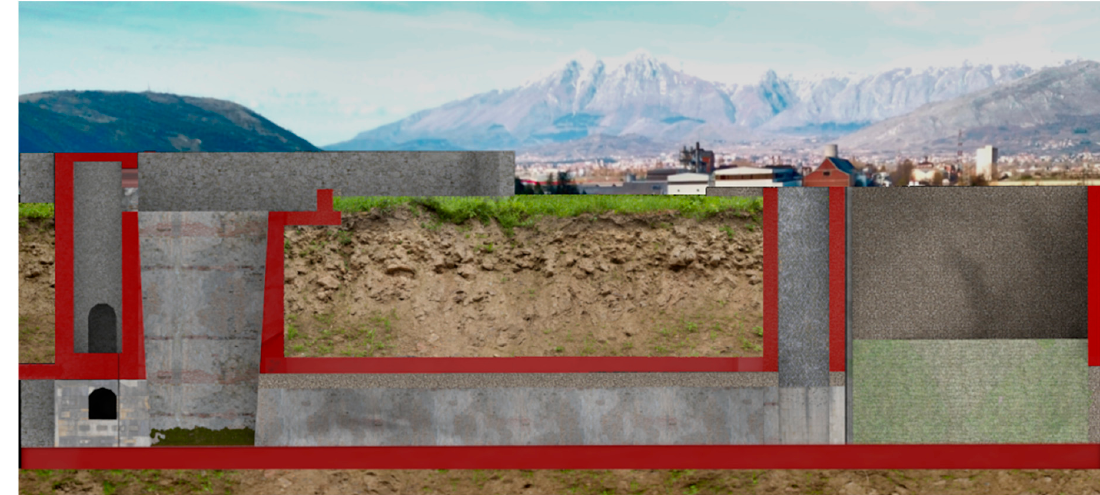
Figure 14. Longitudinal section of the Roman incile in a current setting performed by the 3D virtual reconstruction.